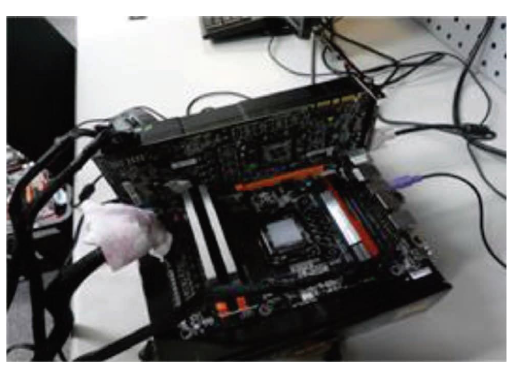
Figure 14: Experimental test platform.